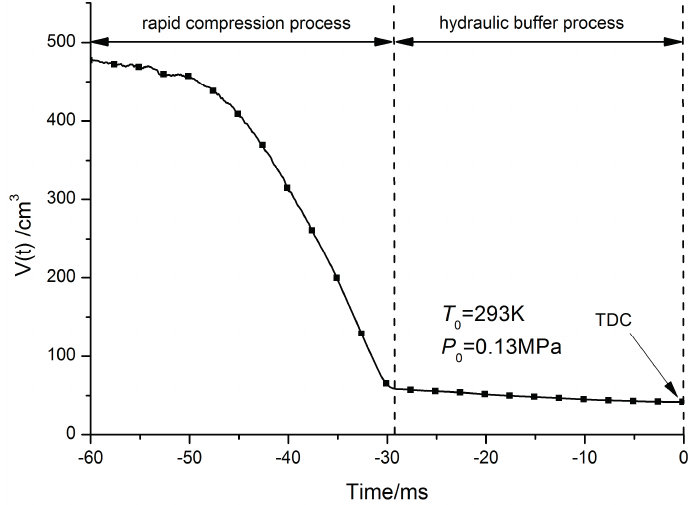
Figure 5. Volume variation of nitrogen in the RCM (before modification of the hydraulic